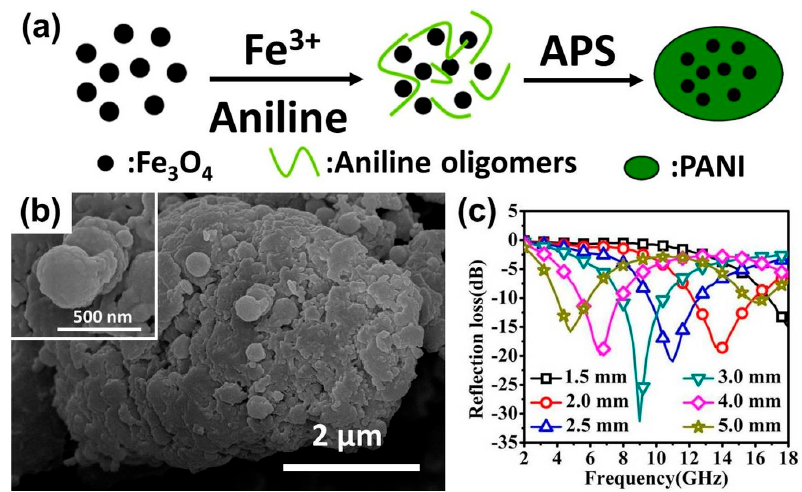
Figure 6. ( a ) Possible formation mechanism; ( b ) SEM image; and ( c ) reflection loss curves dependent on the thickness of “egg-like” Fe 3 O 4 microspheres/PANI composites. Reprinted with permission from Reference [86].